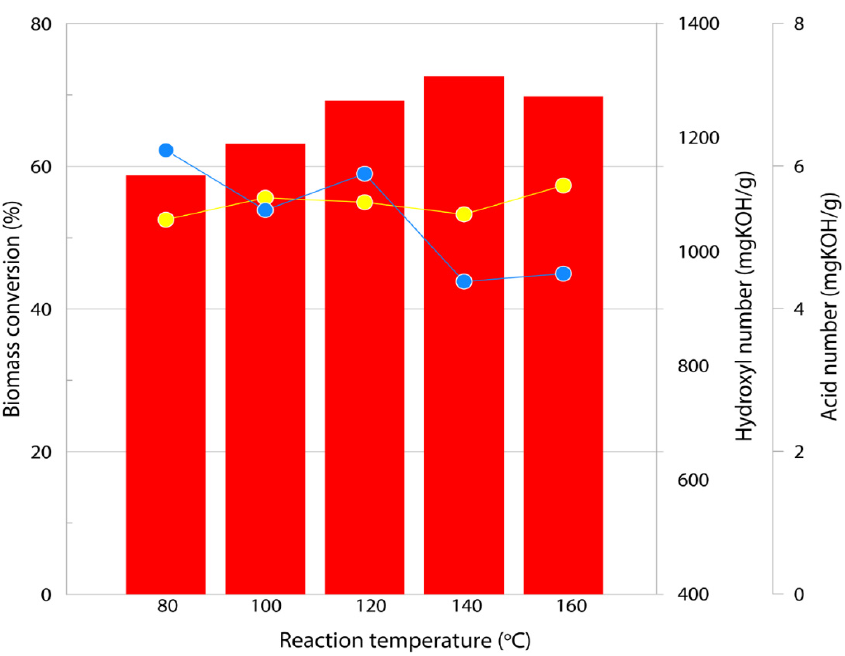
Figure 5. Effect of reaction temperature on biomass conversion and biopolyol acid number (blue line) and hydroxyl number (yellow line). Reaction condition: solvent blending ratio, 1:2; biomass loading, 20%; catalyst loading, 1%; reaction time, 10 min.